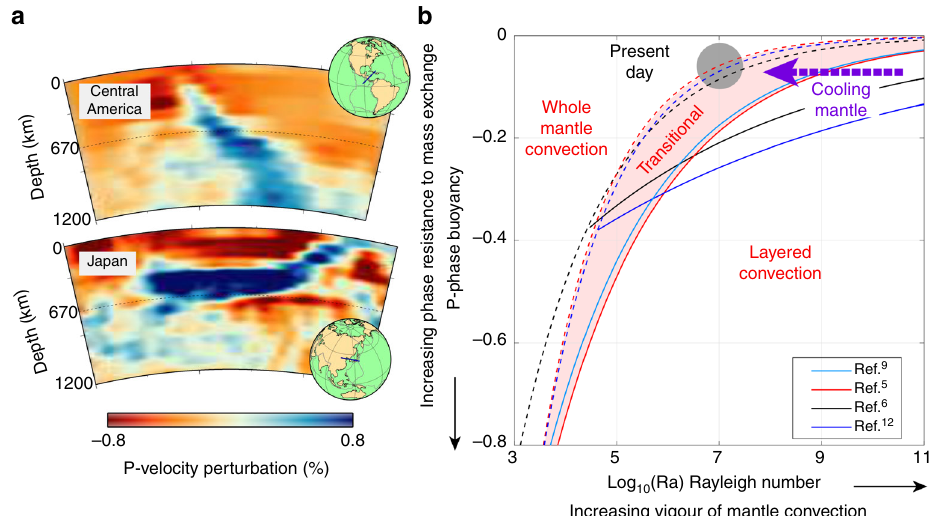
Fig. 1 Present and previously predicted mantle convection styles. a Examples from seismic tomography of a slab readily penetrating the transition zone (below Central America) and a slab that has ponded (below Japan), obtained using the 3D MIT-P08 seismic velocity model of Ref. 69 . b Regime diagram showing how previous studies 5,6,9,13 predict that the style of mantle convection varies with buoyancy number P (the ratio of the phase buoyancy of the endothermic phase transition hampering slab sinking over the thermal buoyancy which drives slab sinking) and Rayleigh number (the ratio of convection- driving over convection-resisting forces, which increases proportionally to mantle temperature). All studies agreed that the critical phase buoyancy required to layer convection decreases (becomes less negative) with increasing Rayleigh number. The grey circle represents the estimated present-day conditions [from Ref. 6 ] and the arrow the likely change from layered convection in an early Earth to a transitional mode